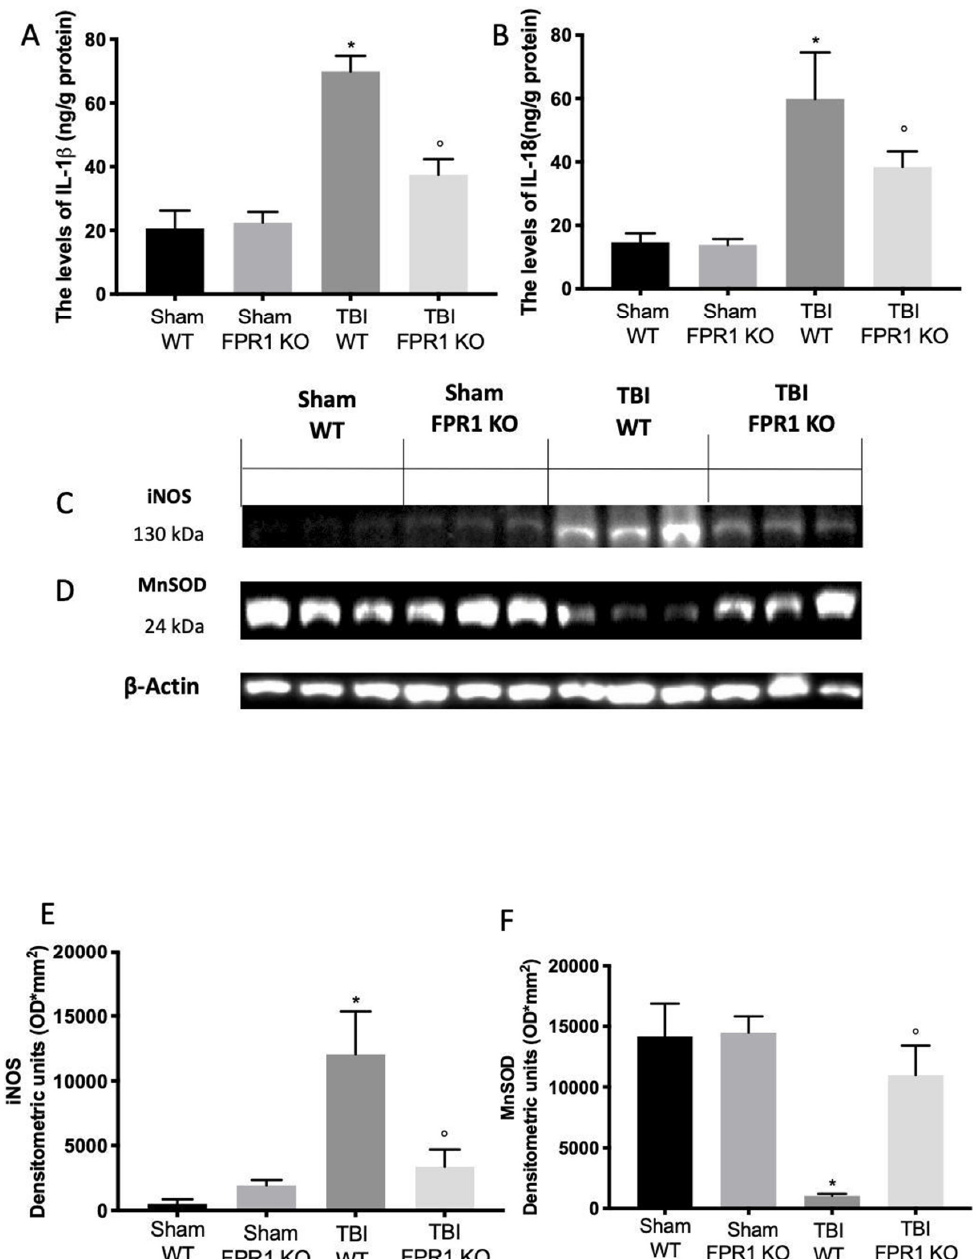
Figure 7. Effect of the absence of Fpr1 on IL-1β, IL-18 and lipid peroxidation: ELISA analysis shows a positive expression of IL-1β ( A ) and IL-18 ( B ) in samples collected from TBI WT animals 24 h after injury. A substantial reduction of these expressions is detected in samples from TBI Fpr1 KO animals ( A , B ) Western blot analysis shows an upregulation of iNOS expression ( C ) in the TBI WT group 24 h after injury, compared to the Sham WT and Sham Fpr1 KO group. Fpr1 KO animals 24 h after TBI show reduced levels of iNOS compare to the TBI WT group; see the densitometric analysis ( E ) The same analysis shows basal expression of MnSOD ( D ) in the Sham WT group and Sham Fpr1 KO group. A significant reduction in MnSOD expression is expressed in the TBI WT group 24 h after injury, while TBI Fpr1 KO animals show a restored expression activation of the anti-oxidant enzyme; see the densitometric analysis ( F ) For the analyses, n = 5 animals from each group were employed. Results were analyzed by two-way ANOVA followed by a Bonferroni post-hoc test for multiple comparisons. Non-parametric data were analyzed with Fisher’s exact test. * p < 0.05 vs. Sham WT; ◦ p < 0.05 vs. TBI